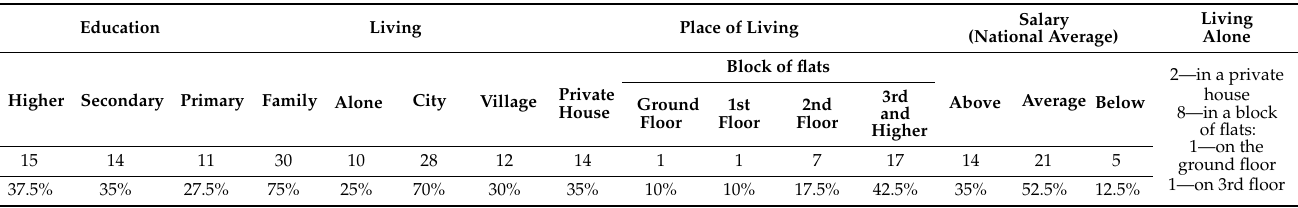
Table 2. Socio-economic status of